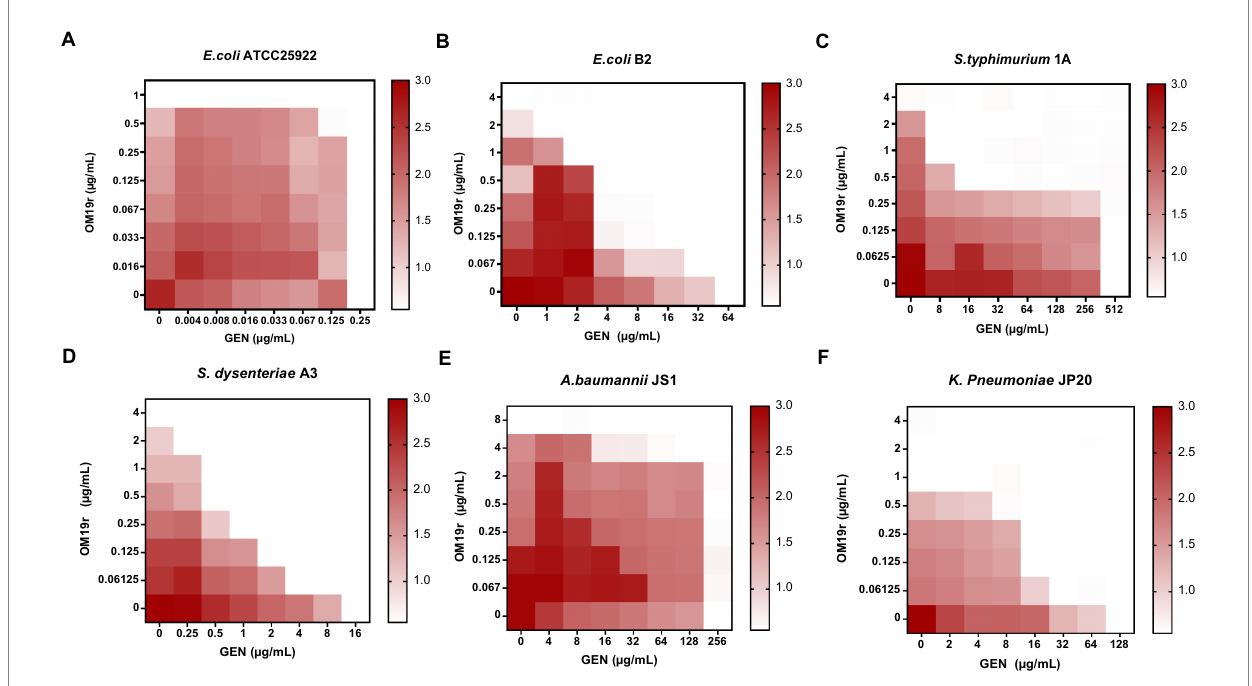
FIGURE 1 OM19r enhances the antibacterial activity of GEN against some Gram-negative bacteria. (A–F) Checkerboard test results of OM19r combined with GEN against E. coli ATCC25922, E. coli B2, S. typhimurium 1A, A. baumannii JS1, S. dysenteriae A3, and K. pneumoniae JP20. The X-axis represents